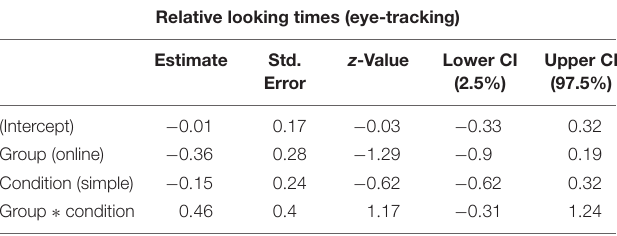
TABLE 1 | Results of the GLMM of trial-level relative looking times to the synchronous stimulus measured with eye-tracking, with estimates, standard errors, z -values, and confidence intervals (CIs).